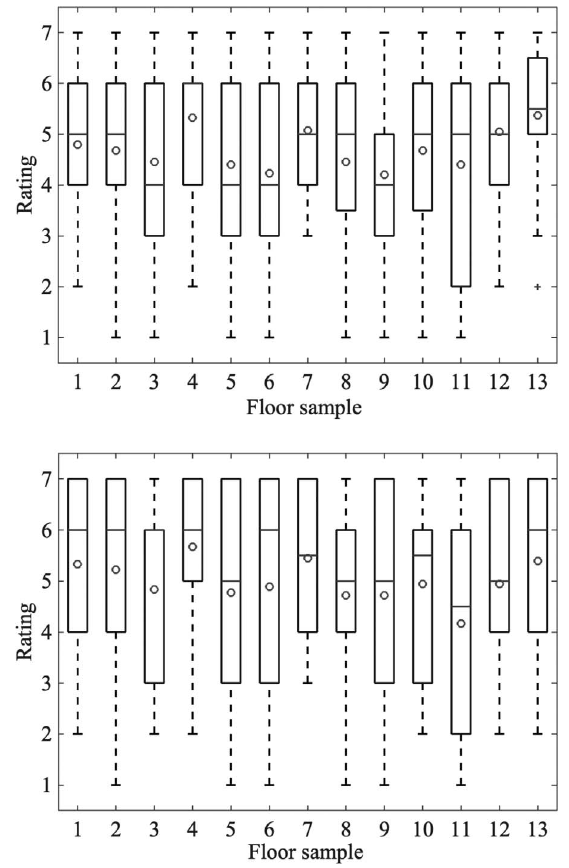
Figure 13. Assessment of naturalness of walking sound sam- ples. The circles show the mean values of the data. The results from all subjects are shown in the upper fi gure while for only those who have experienced impact sound from wooden fl oors are shown in the lower fi